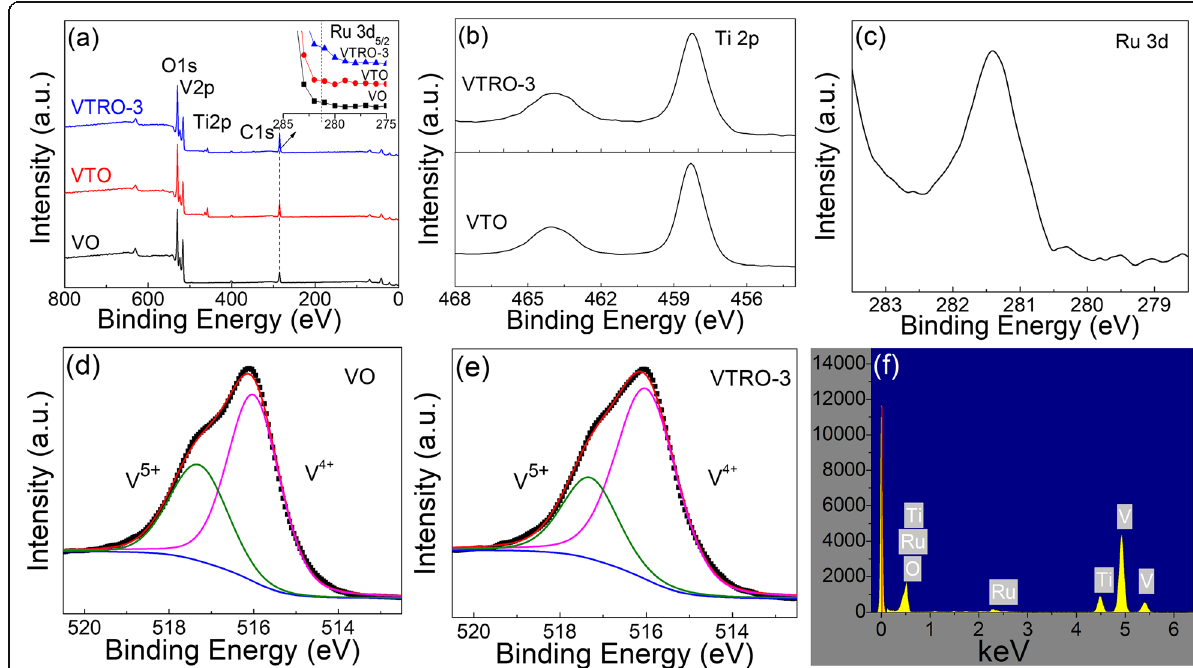
Fig. 1 a XPS survey spectra of VO, VTO, and VTRO-3, deconvoluted XPS spectra of b Ti 2p, and c Ru 3d for VTRO-3, d V 2p 3/2 XPS spectra for VO and VTRO-3, e EDS spectrum of VTRO-3